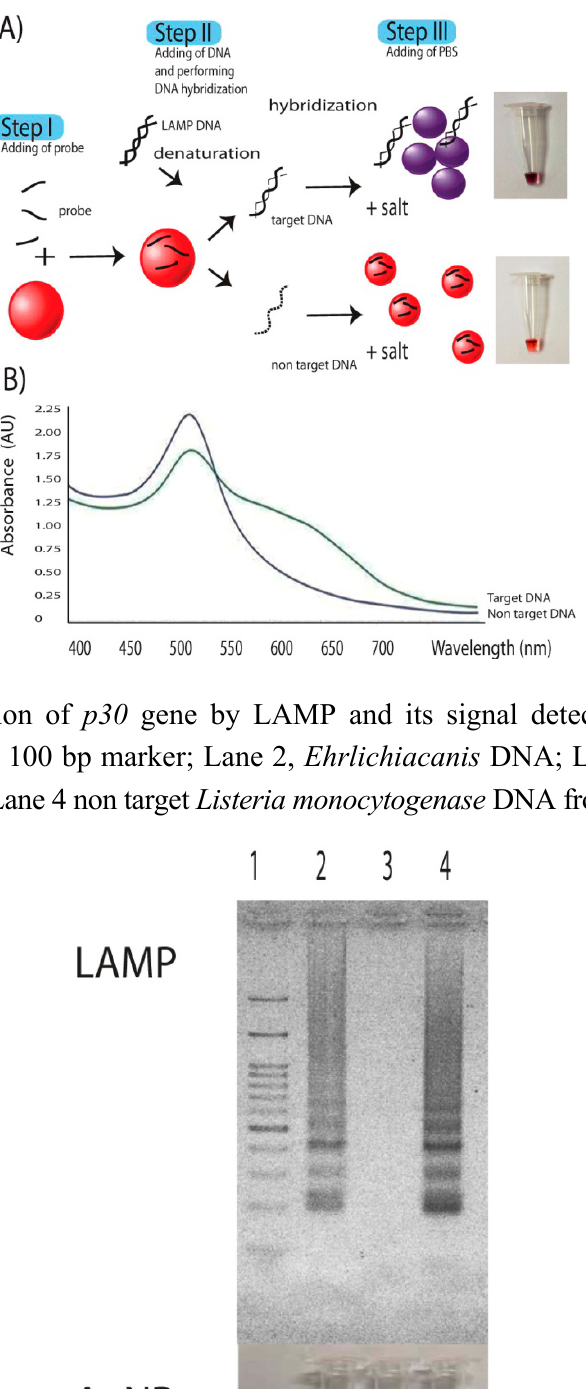
Figure 2. Schematic of a colorimetric DNA detection of p30 DNA based on gold nanoparticles and its corresponding change in UV-Vis spectrum.